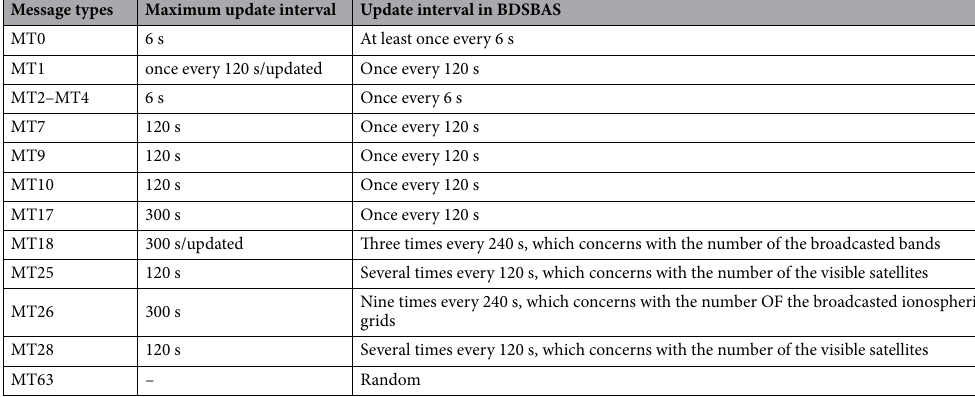
Table 3. Update interval of the augmentation message in